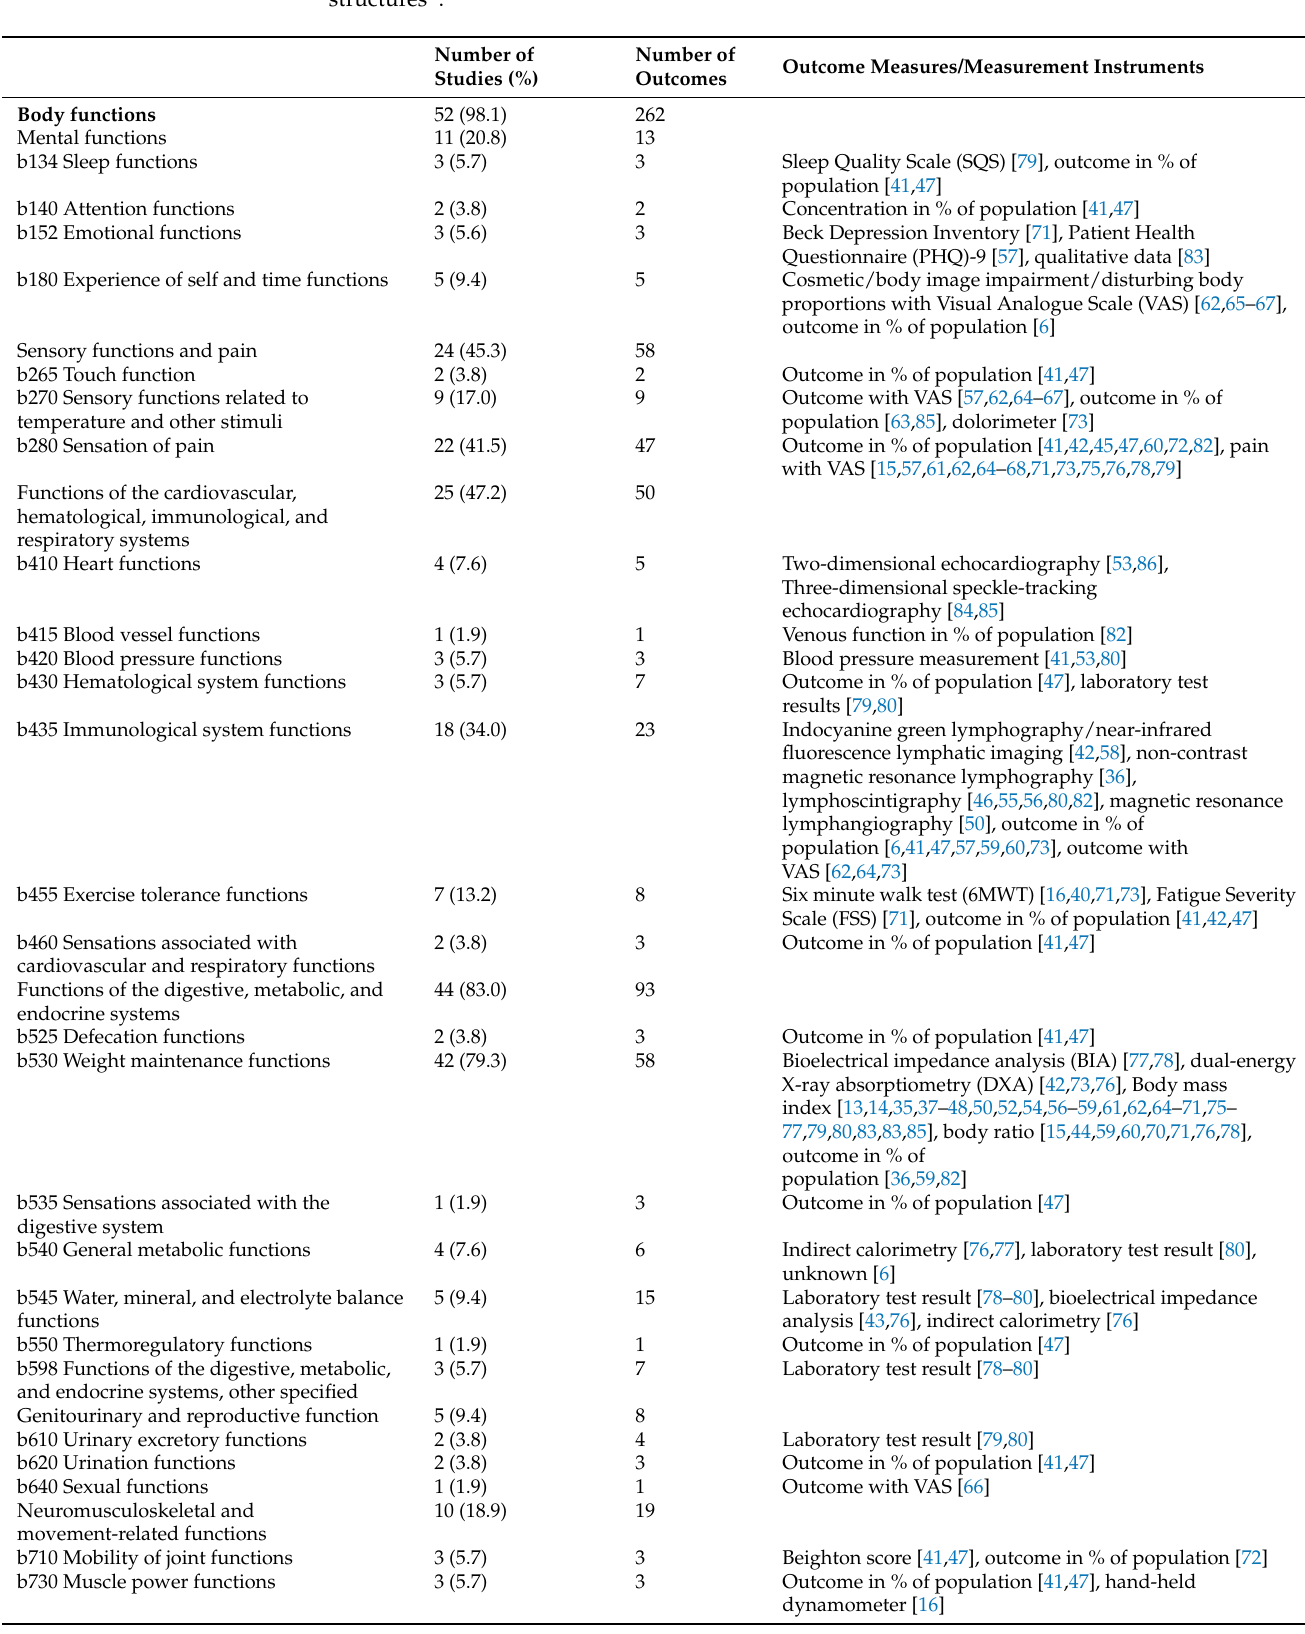
Table 1. Frequencies of codes and outcomes used within the theme “body functions” and “body